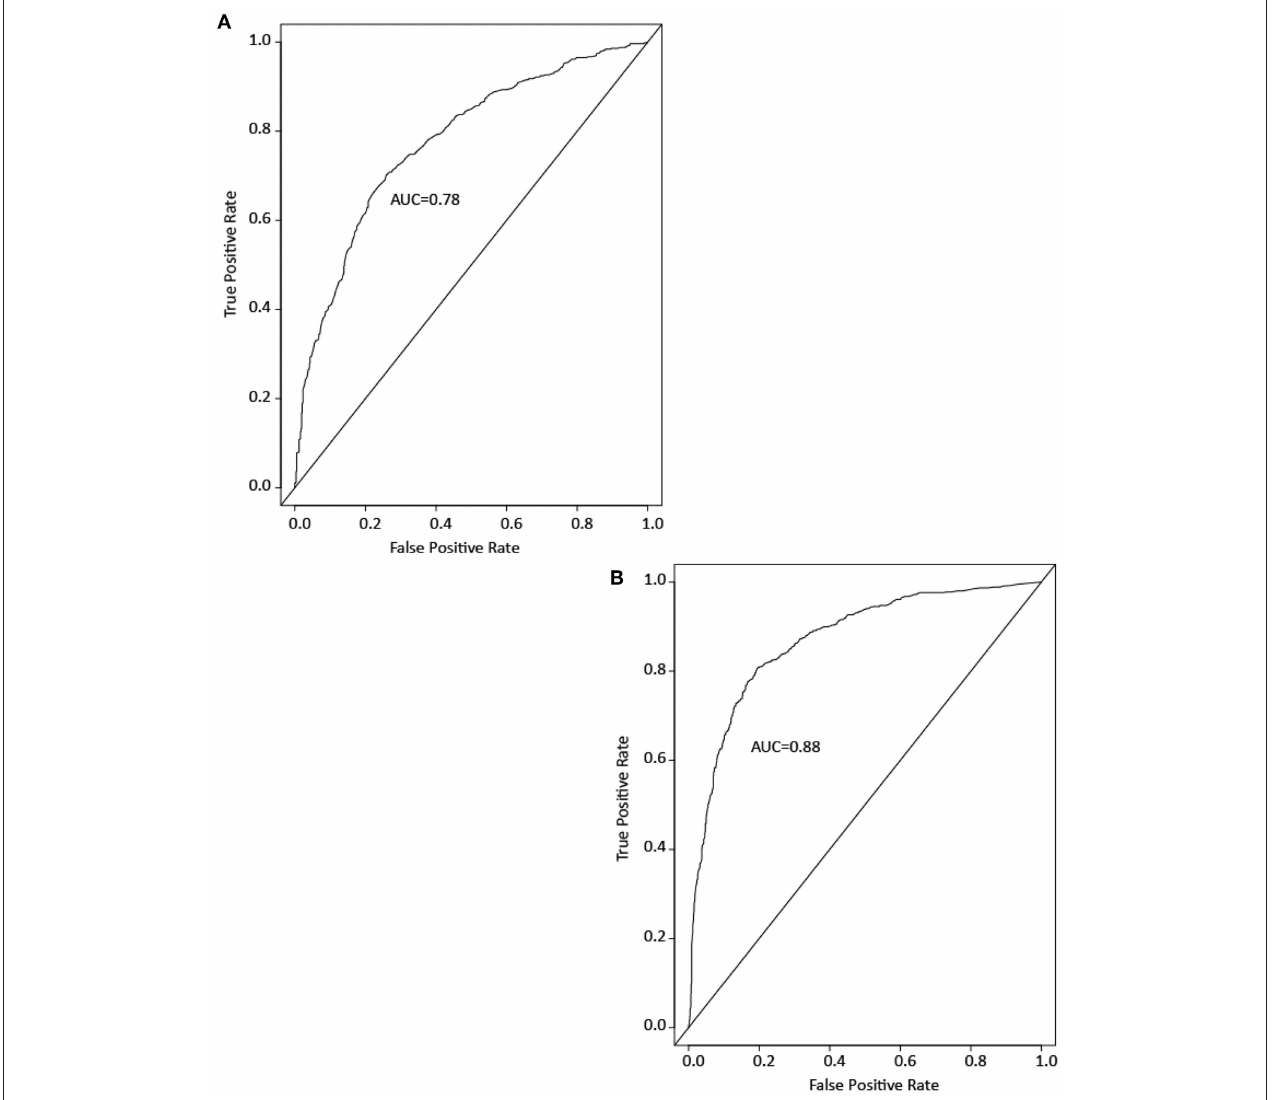
FIGURE 5 | Example ROC curves of drug prediction models based on (A) assay activity and (B) chemical structure. Model performance is measured by the area under the ROC curve